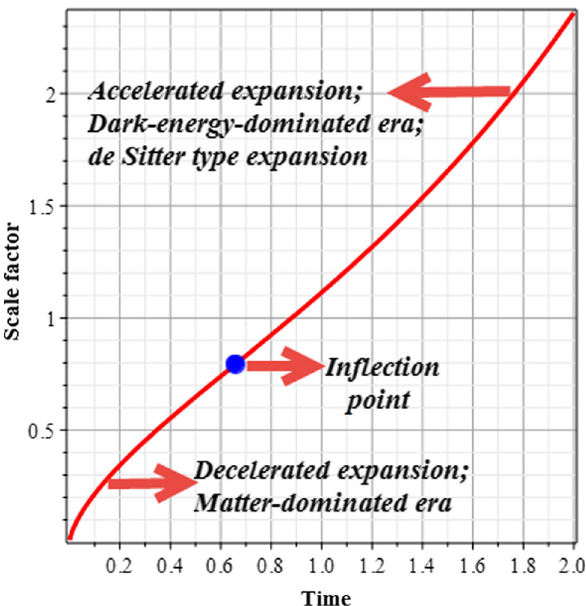
Fig. 1 Thisfigureindicatesthequalitativebehaviorofscalefactor(11) − (cid:4) c 2 ) 1 / 3 = 1, and ω = for the values λ( c 2 4 2